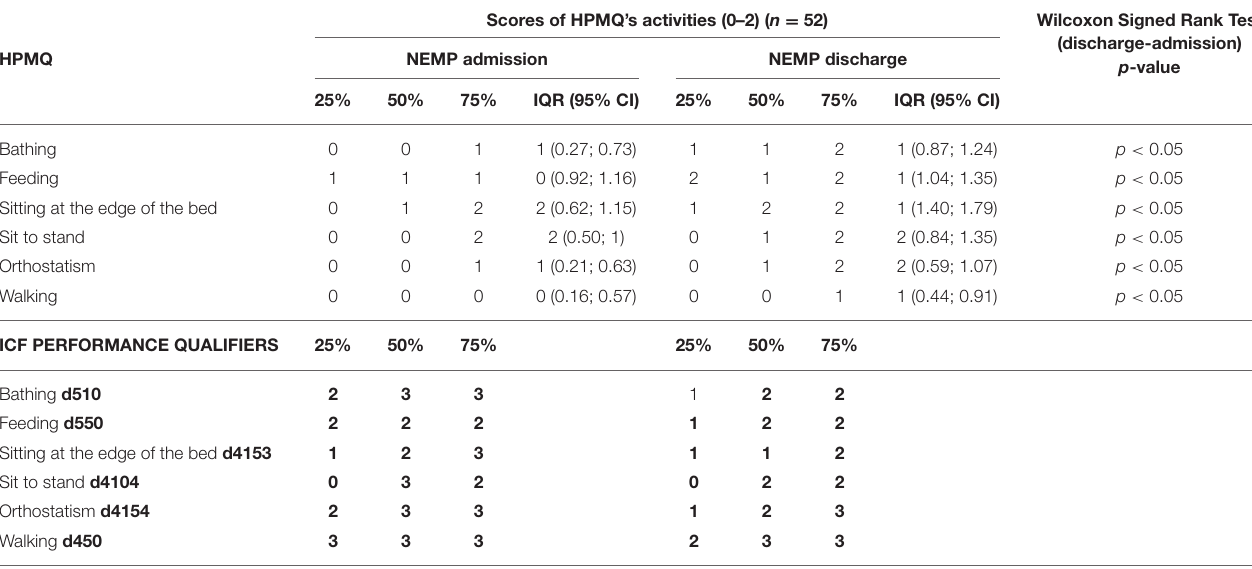
TABLE 7 | Descriptive outcomes from HPMQ in NEMP admission and discharge and comparison of these two time points through Wilcoxon Signed Rank Test, HPMQ re-codification into ICF performance qualifier. Scores of HPMQ’s activities (0–2) ( n =